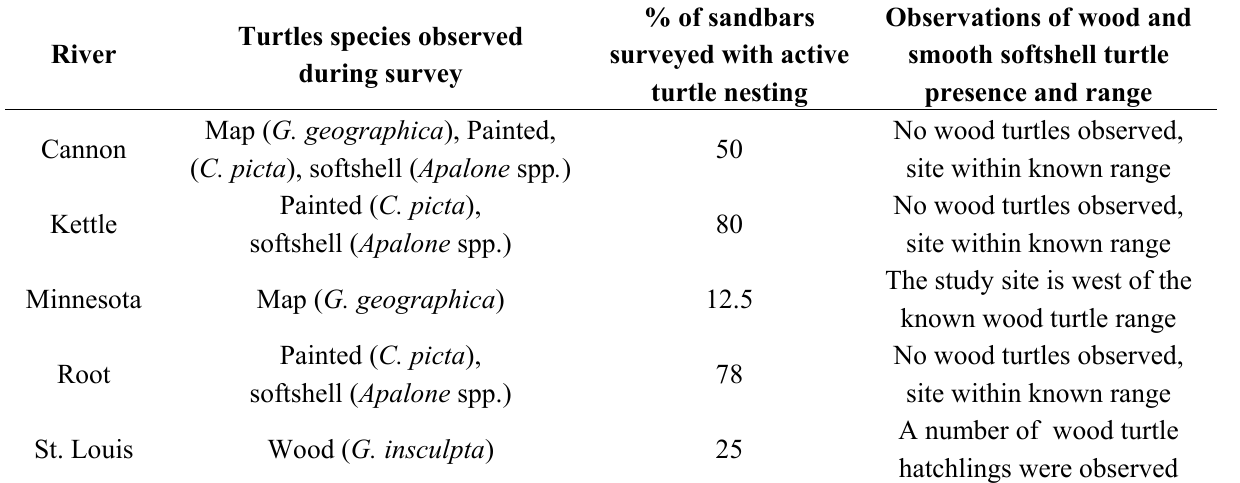
Table 5. Turtle nesting species observation data on study rivers in summer 2010–2011. Turtle species observations were recorded for the entire study reach while canoeing. A subset of sandbars ( n = 5–10 per river) was examined more closely for nesting